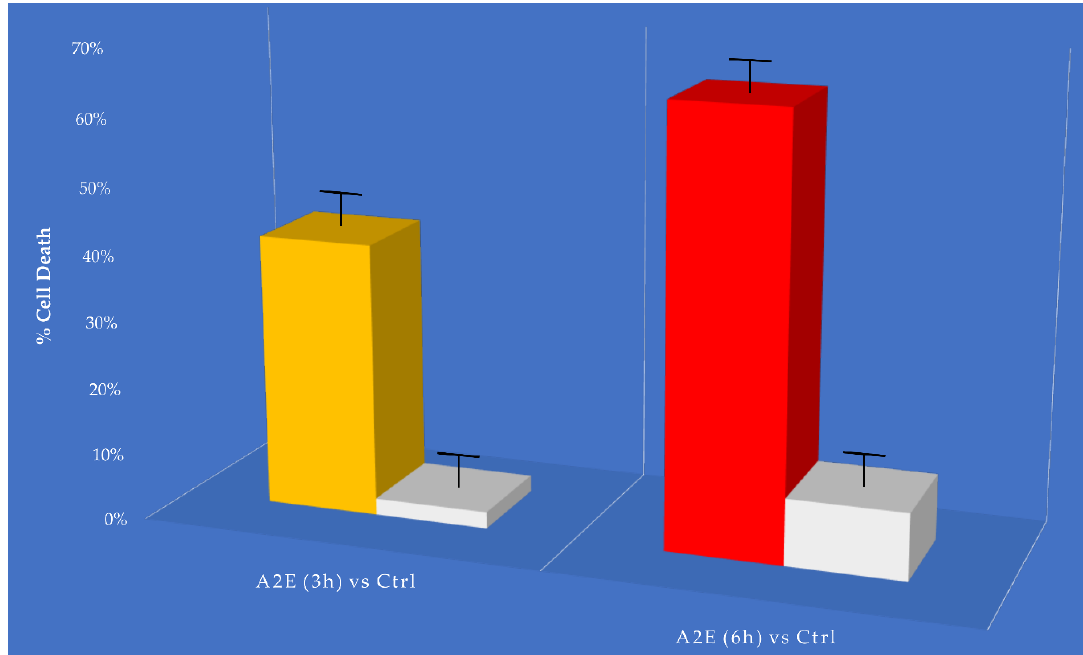
Figure 1. MTT determination of A2E treatment in retinal pigment epithelium (RPE) cells. Cell death was assessed at considered time points (3 h and 6 h) in A2E treated samples compared to basal untreated group. Results are shown as mean ± standard error of mean ( n = 3). p -value < 0.05.